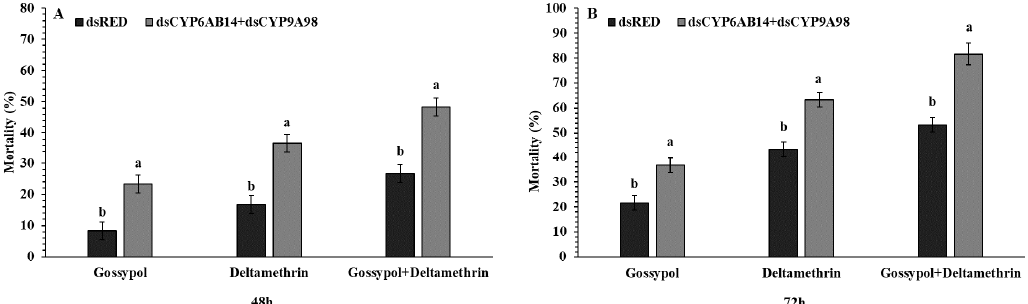
Figure 5. Combined effect of dsCYPAB14+dsCYPA98 feeding on the mortality of fourth instar S. exigua larvae. Following the droplet-feeding with dsCYPAB14+dsCYPA98 or dsRED for 24 h the exposed larvae were transferred individually into 12-oriface tissue culture plate containing artificial diets supplemented with 0.1 % gossypol, LC 50 concentration of deltamethrin 0.887mg/L for 48 ( A ) and 72 h ( B ) or 0.1 % gossypol for 24 h followed by deltamethrin for 48 ( A ) and 72 h ( B ). Data shown are means ± SE derived from three biological replicates. Di ff erent letters above bars indicate significant di ff erences ( p < 0.05) according to the Student’s t